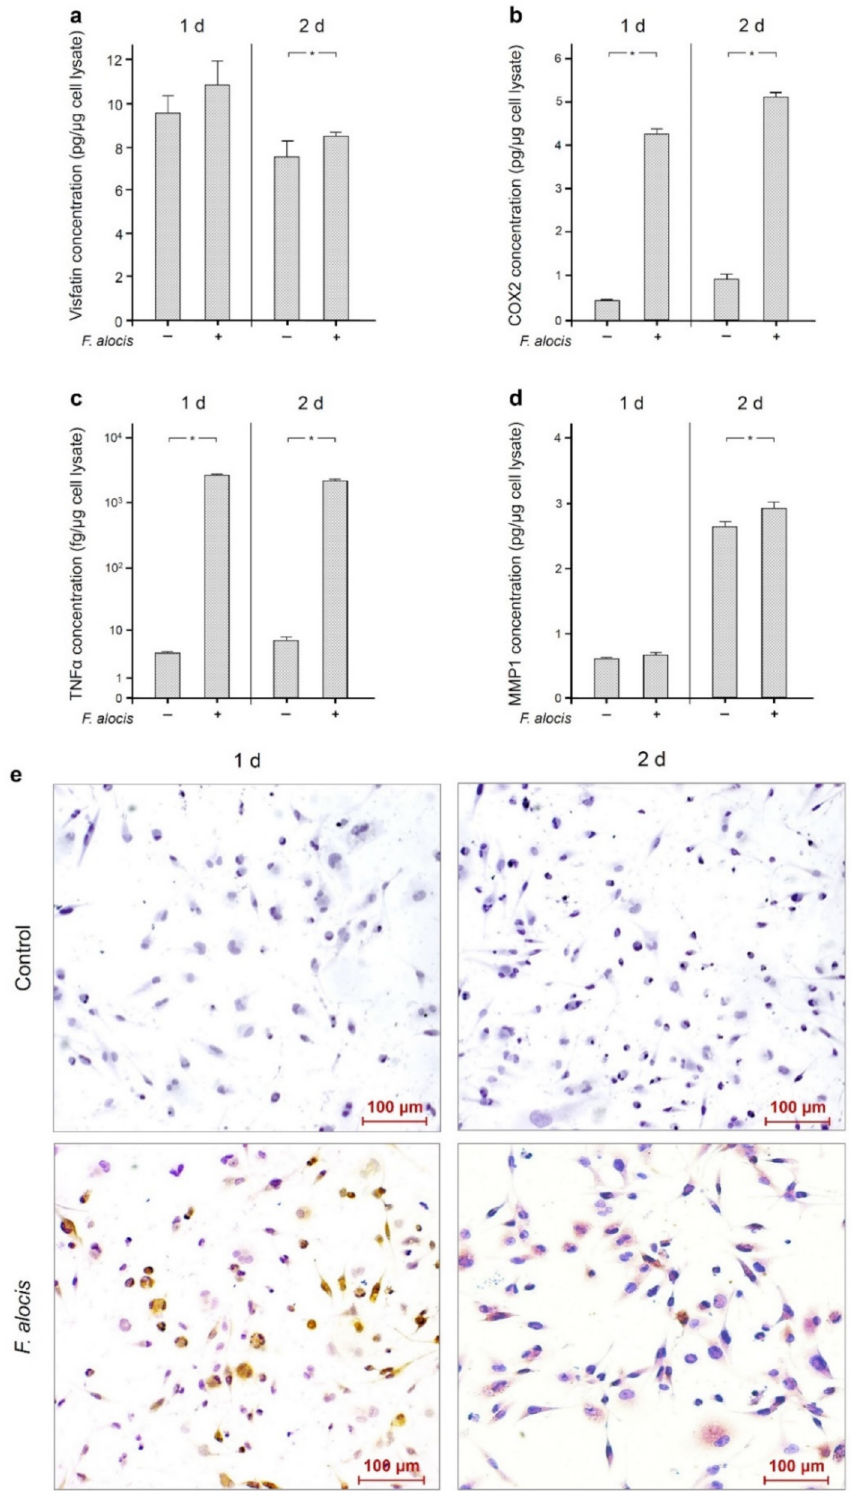
Figure 3. Visfatin ( a ), COX2 ( b ), TNF α ( c ), and MMP-1 ( d ) protein levels in the presence and absence of F. alocis (OD 660 : 0.1) after 1 d and 2 d, analyzed by ELISA. Mean ± SEM, n = 18/group. * significant ( p < 0.05) difference between groups. Visfatin protein in the presence and absence of F. alocis (OD 660 : 0.1) in human macrophages at 1 d and 2 d as visualized by immunocytochemistry ( e ). Shown are representative images from one of three